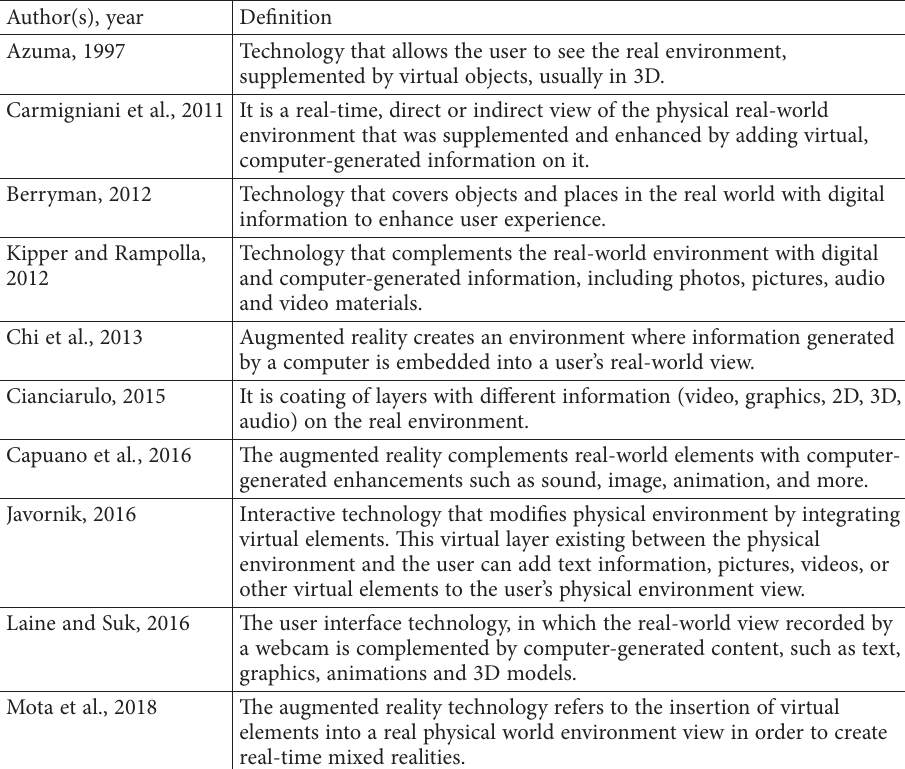
Table 1. Augmented reality concept (source: created by the